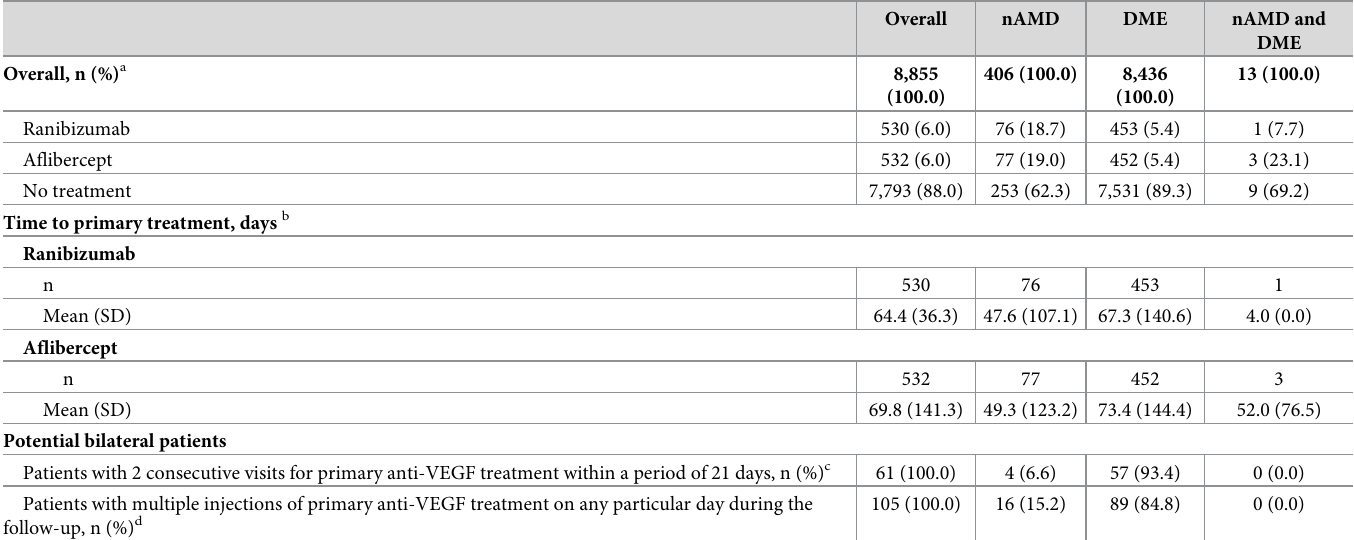
Table 2. Anti-VEGF treatment pattern after